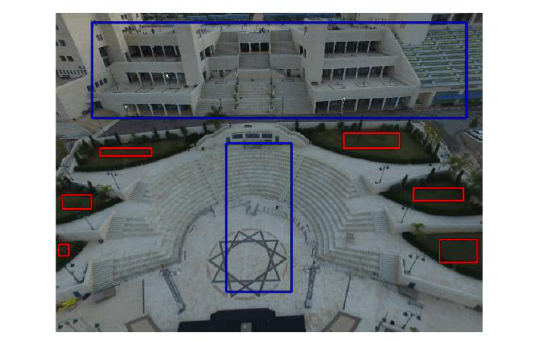
Figure 3. University open theater image with initial seed rectanglesused to apply segmentation and space calculation algorithm of multiple green areas